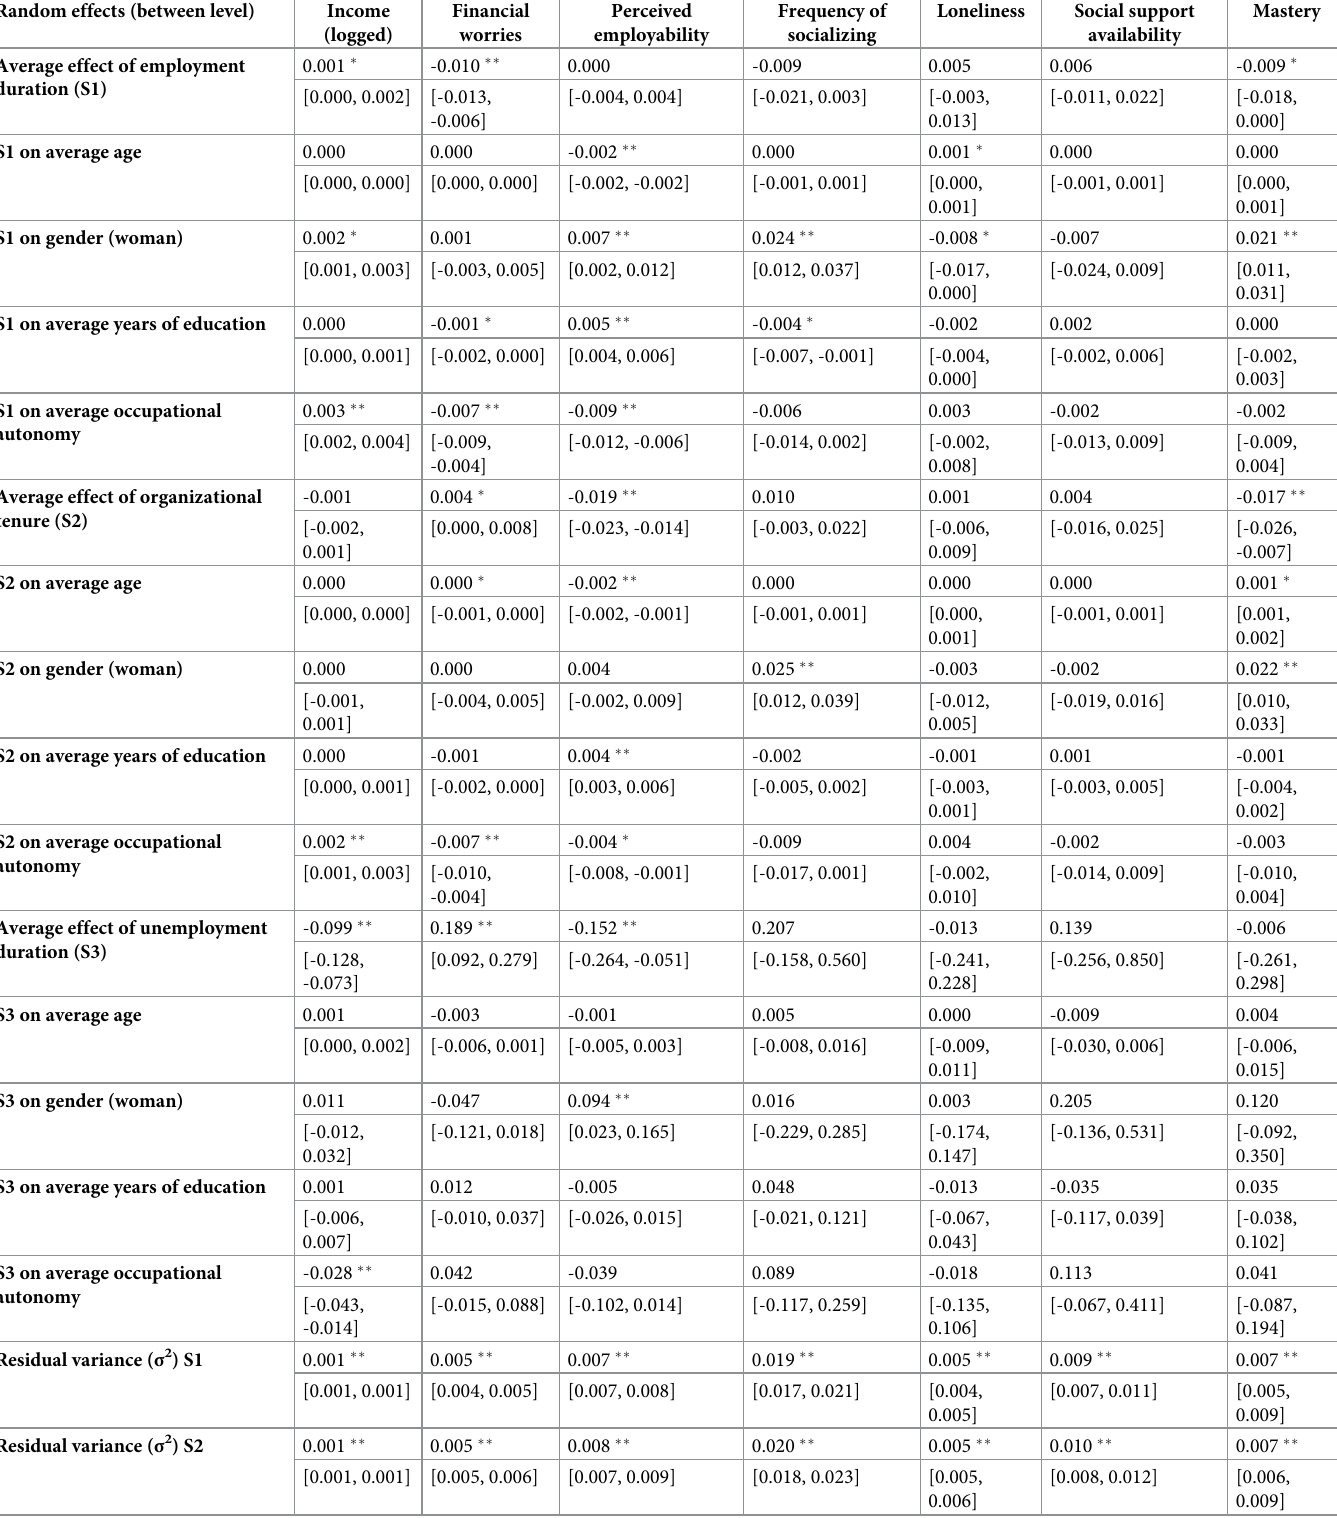
Table 3. Moderation of the within-level effects of employment status duration on resources by between-level